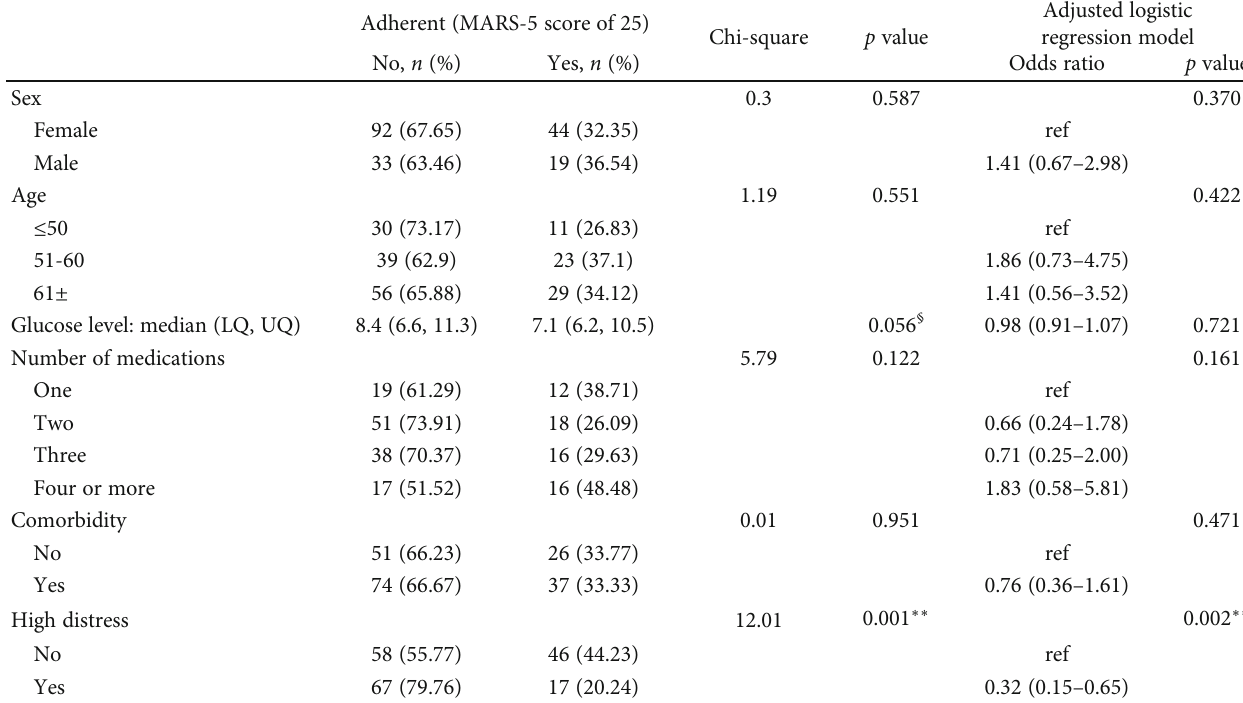
Table 3: Association between background and clinical characteristics and medication adherence status of patients with T2DM receiving treatment at Pantang